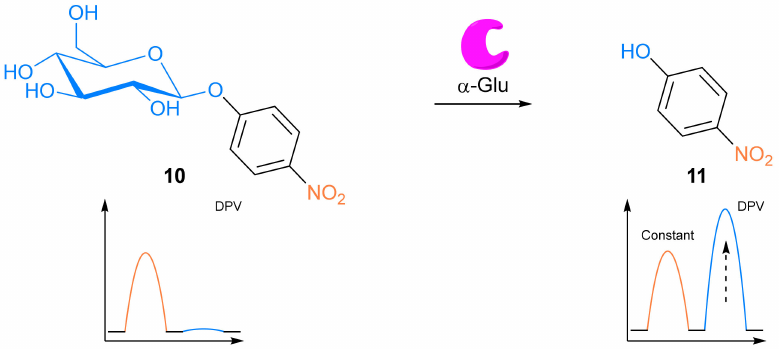
Figure 48. Schematic representation of a chemodosimeter for the detection of α -glucosidase ( α -Glu).